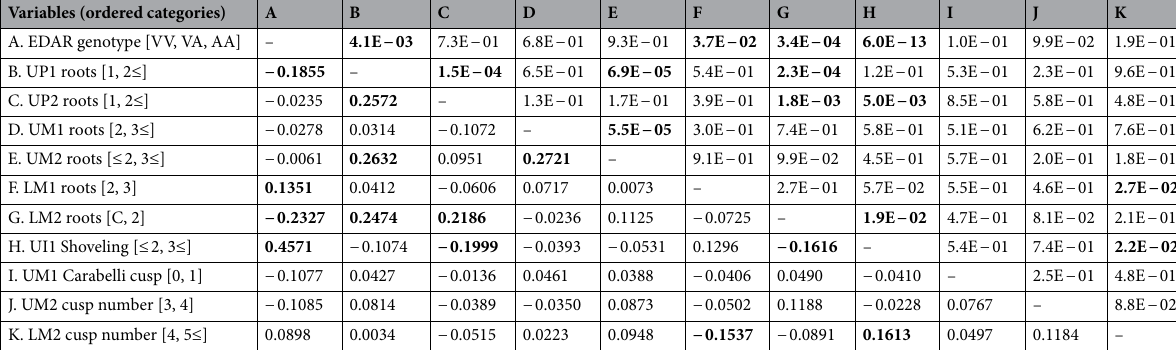
Table 3. Spearman’s rank correlation coefficients between dental traits. Lower left: Spearman’s rank correlation coefficients. Upper right: P values. Bold: significant